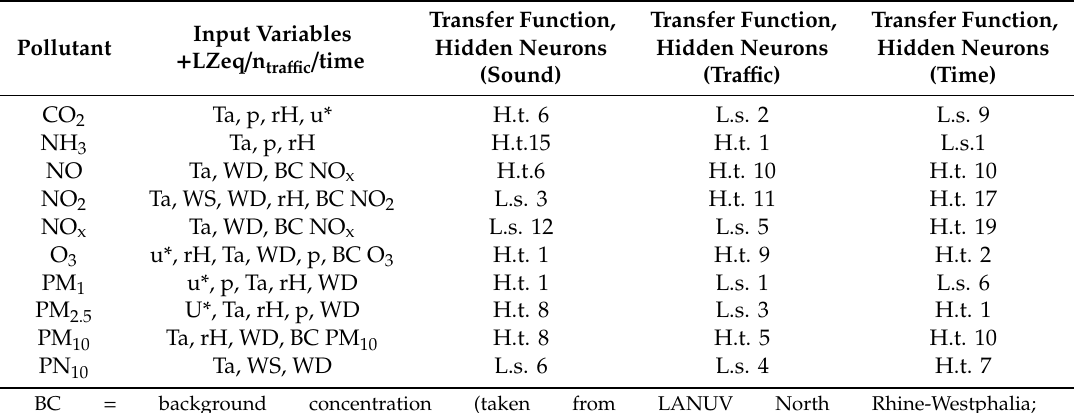
Table 4. Model architecture for each